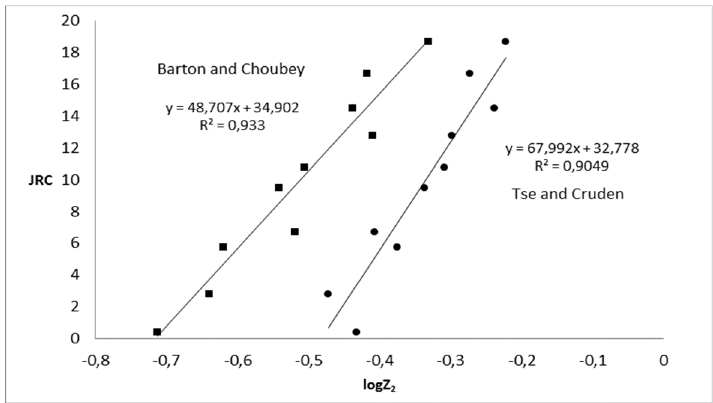
Figure 4. Graph comparing the JRC-logZ 2 relationship extracted from Tse and Cruden’s [3] and Barton and Choubey’s [4] image.